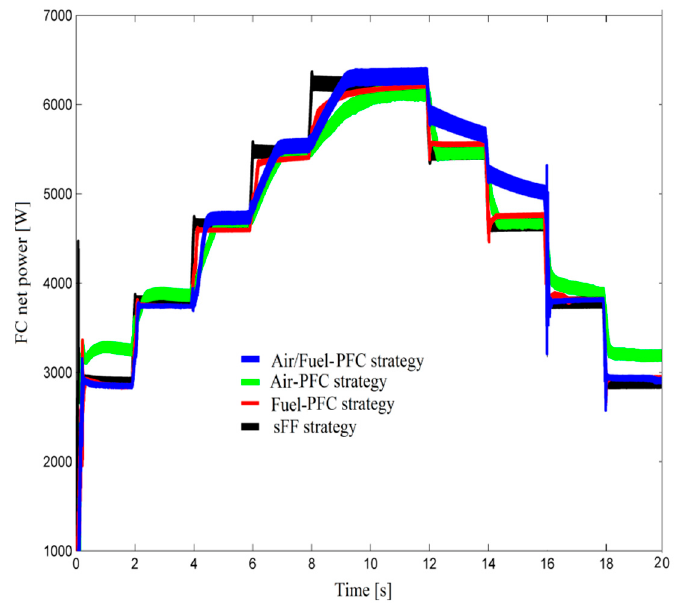
Figure 8. FC net power [34].